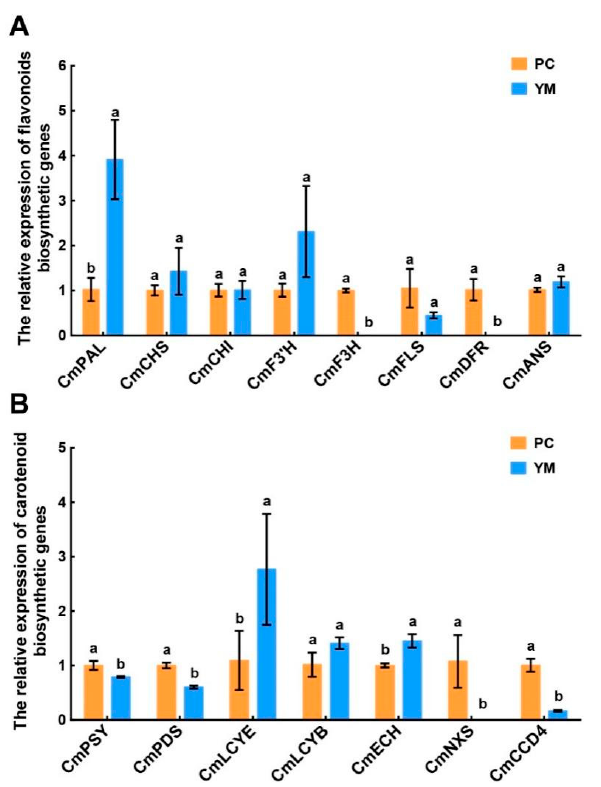
Figure 6. The relative expression levels of genes related to the biosynthesis of flavonoids ( A ) and carotenoids ( B ) in the ray florets of PC and YM. Different letters indicate significant differences at p < 0.05 according to Duncan’s multiple range test.